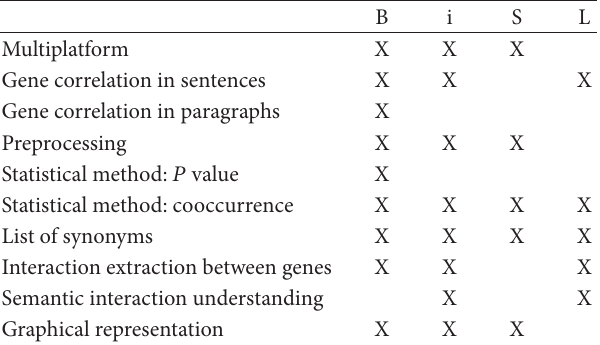
Table 1: Main differences between Biblio-MetReS (B), iHOP (i), String (S), and Laitor